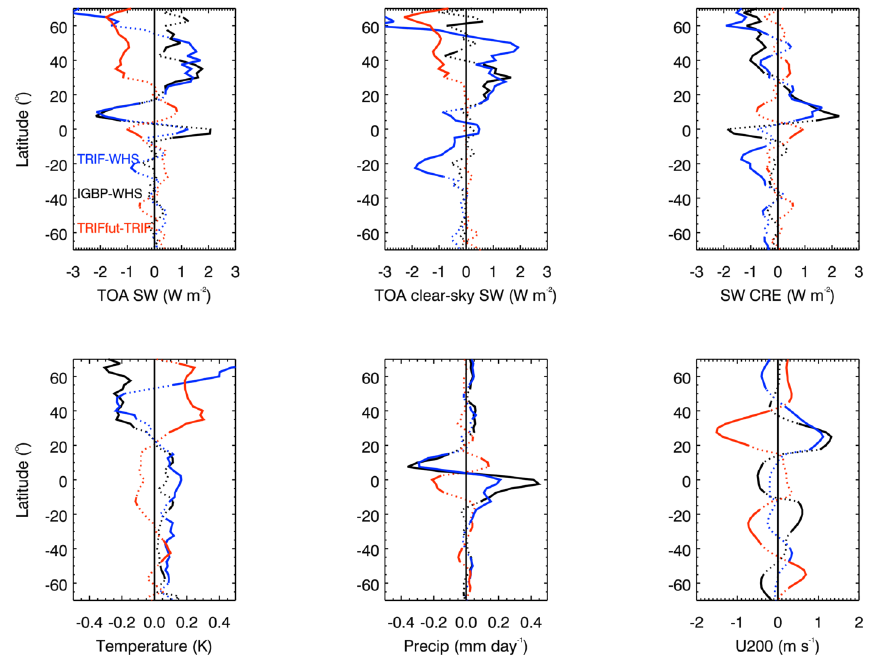
Fig. 2. Climate impact of imposed vegetation for (upper left panel) top of atmosphere (TOA) shortwave (SW), (upper middle panel) TOA clear sky only SW, (upper right panel) Cloud radiative effect in SW, (lower left panel) near surface air temperature, (lower middle panel) precipitation, and (lower right panel) 200hPa zonal wind. The zonal mean differences between (black) IGBP-WHS, (blue) TRIF-WHS, and (red) TRIFfut-TRIF are shown. Unbroken segments represent regions where the difference is statistically significant at the 5% level based on a student’s t-test, while dotted segments are not